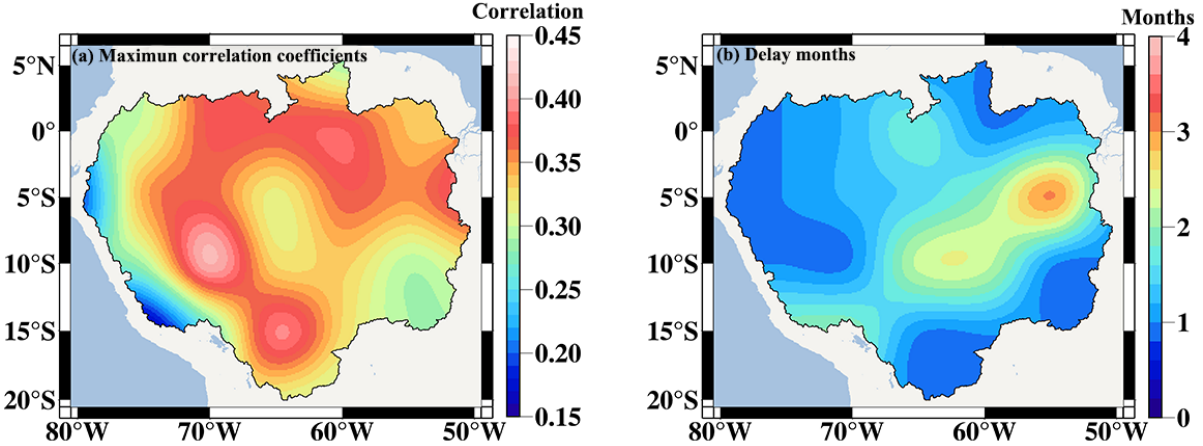
Figure 13. The long ‐ term trend changes and acceleration of GRACE/Swarm ‐ DSI in the ARB during 2003–2020 (The maximum correlation coefficient results in ( a ) have passed the 95% confidence level).